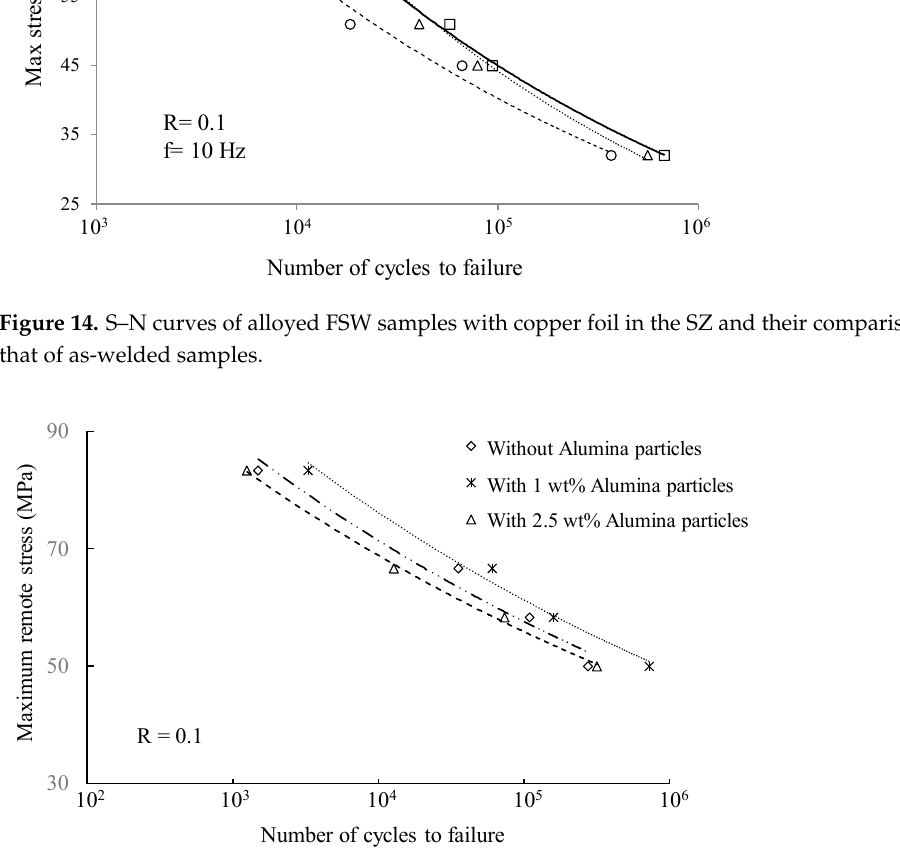
Figure 15. S–N curves of MMC FSSW samples and their comparison with that of as-welded